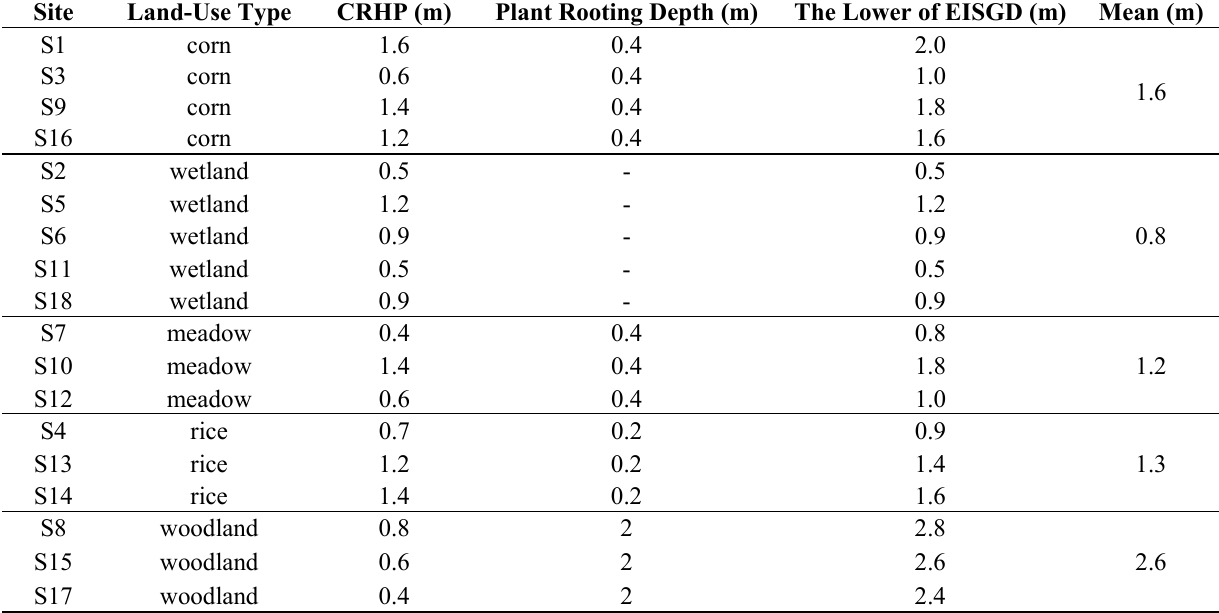
Figure 13. Ranges of ecologically ideal shallow groundwater depth (EISGD) in the Sanjiang Plain, northeast China. Average EISGD was estimated for five major vegetation types including rice paddies (6.7 m), meadows (7.3 m), woodland areas (8.3 m), crop farmland (5.1 m), and wetlands (6.9 m). Table 4. The upper boundary of ecologically ideal shallow groundwater depth (EISGD) of the Sanjiang Plain in Northeast